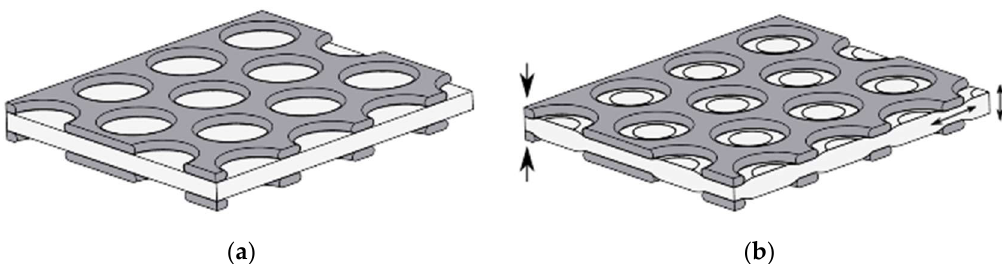
Figure 1. Working principle of dielectric elastomer actuators with rigid perforated electrodes: ( a ) undeformed configuration; and ( b ) configuration deformed by the applied voltage.